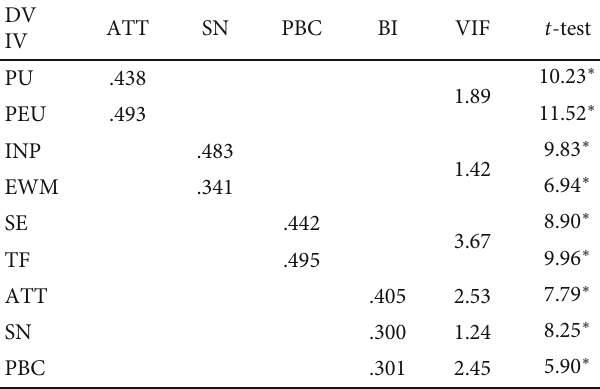
Table 2: NTC app regression analysis